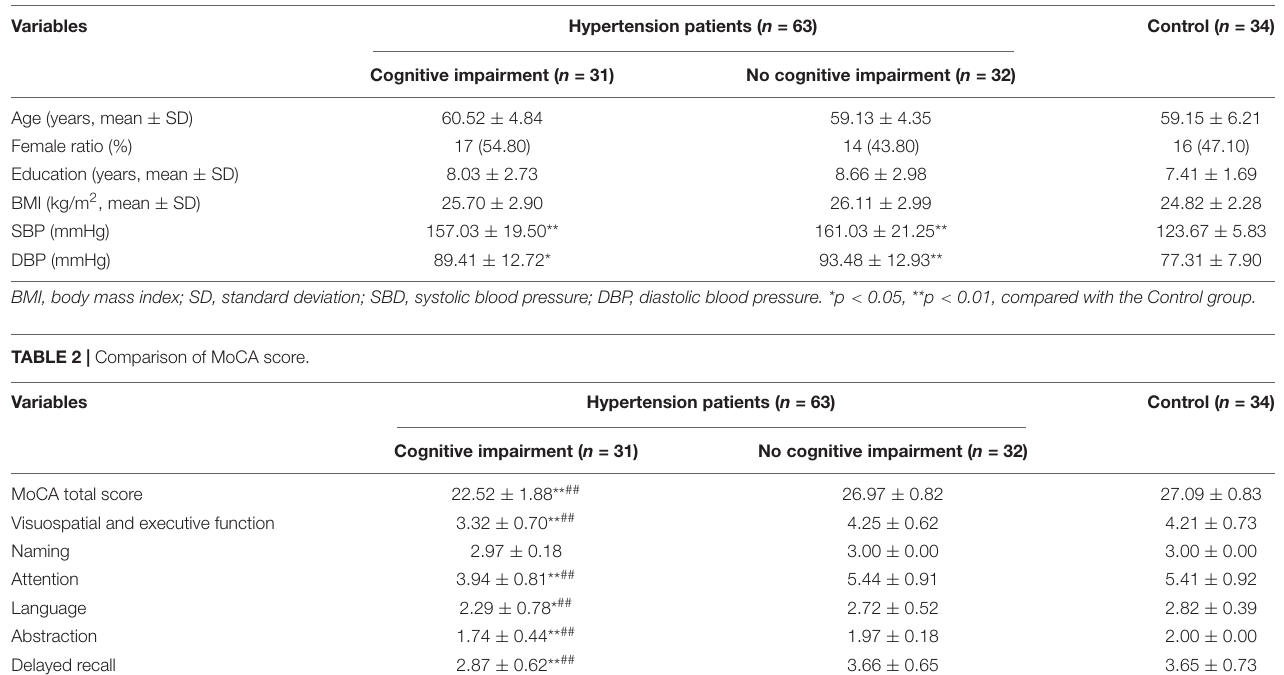
TABLE 1 | Comparison of demographic and clinical characteristics of subjects.